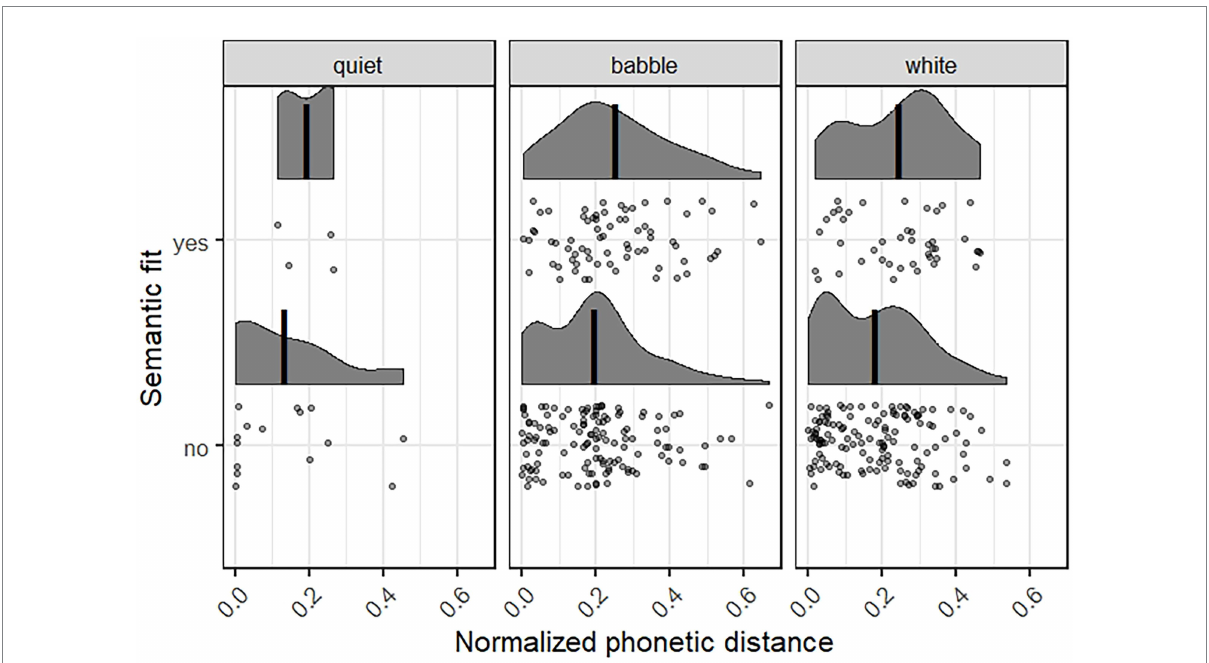
FIGURE 4 The wrong responses that semantically fit or did not fit the sentence, plotted with the normalized phonetic distance, in each of the three noise conditions. Lower phonetic distance means more similar to the target item. The vertical black lines show the mean phonetic distance for each condition. Each dot represents a single wrong response, the shaded curves show the density plots for